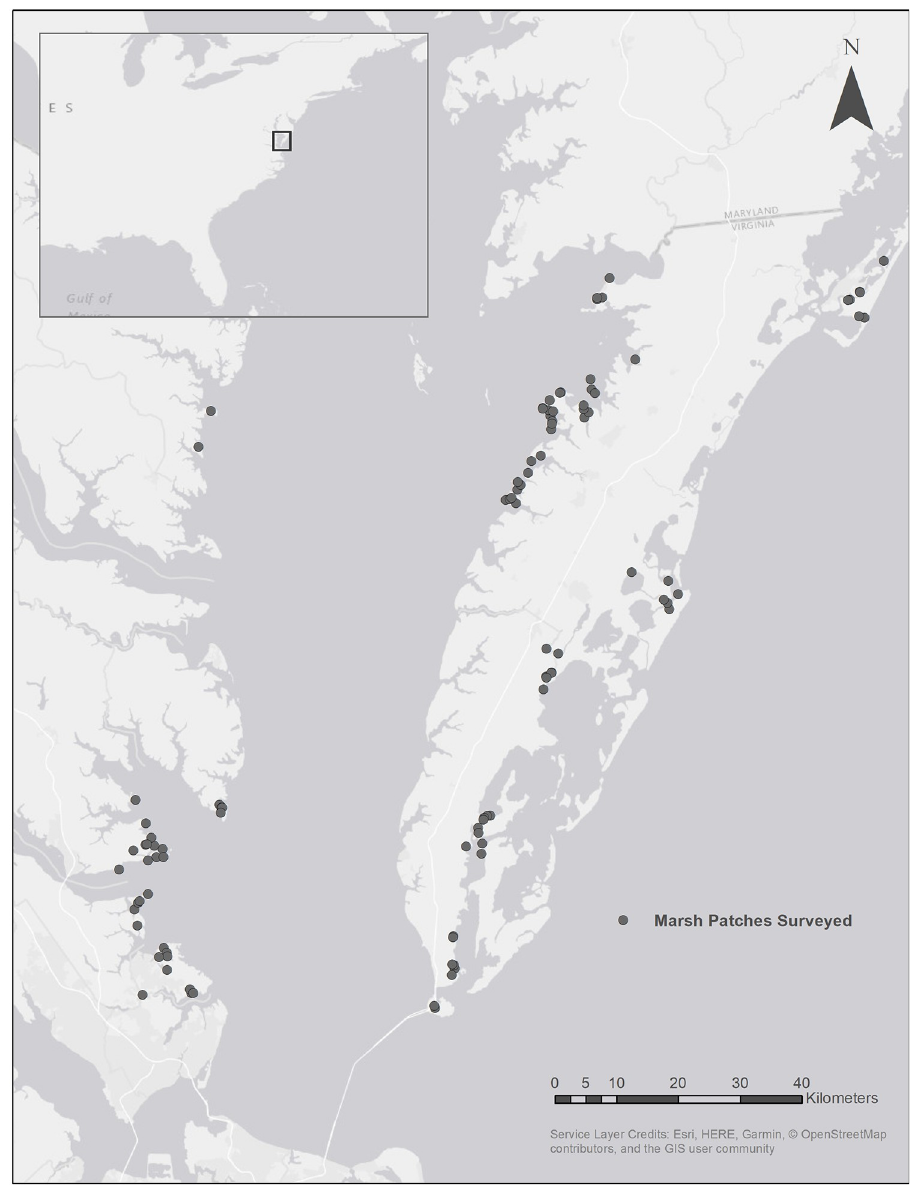
Fig 1. Map of marsh patches surveyed for sharp-tailed sparrows ( Ammospiza nelson and A . caudacutus collectively), seaside sparrows ( A . maritimus ) and marsh wrens ( Cistothorus palustris ) in Virginia, USA during winter 2014 using the double-pass rope-drag technique. Figure was created using ArcGIS 1 10.7.1. Basemap provided by: Esri, HERE, Garmin, © OpenStreetMap contributors, and the GIS user community.